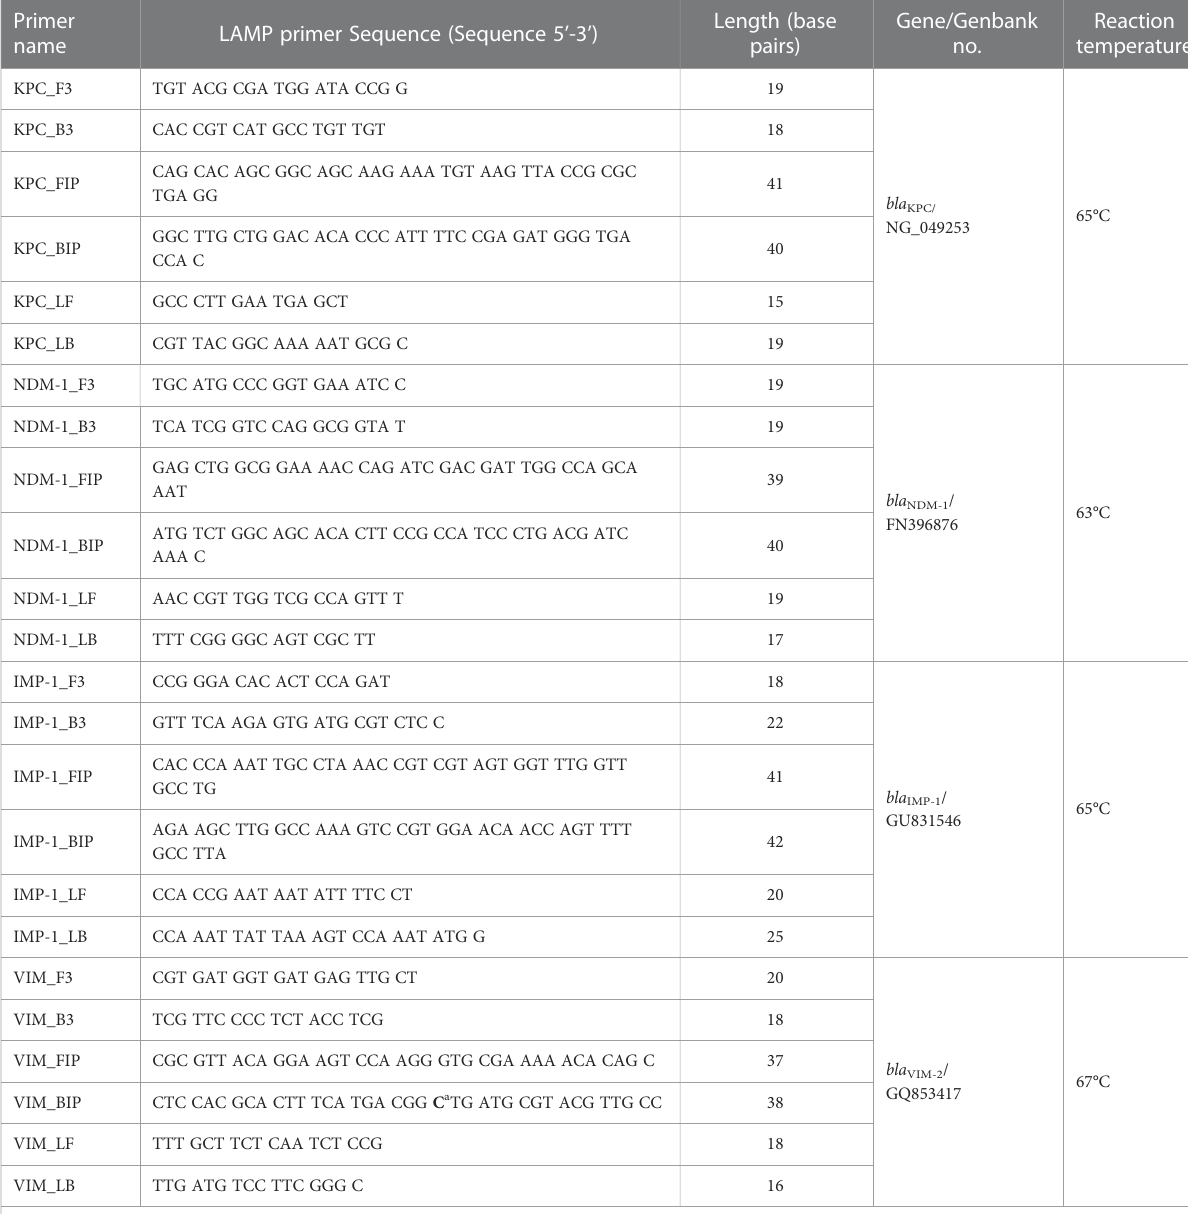
TABLE 3 LAMP primer sequences in this